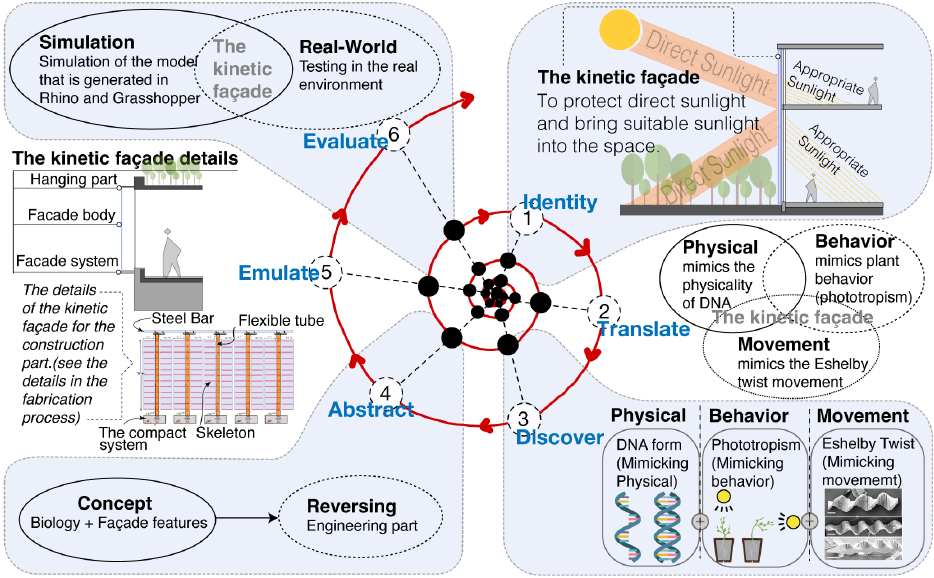
Figure 6. The biomimicry design spiral principle for integration in this